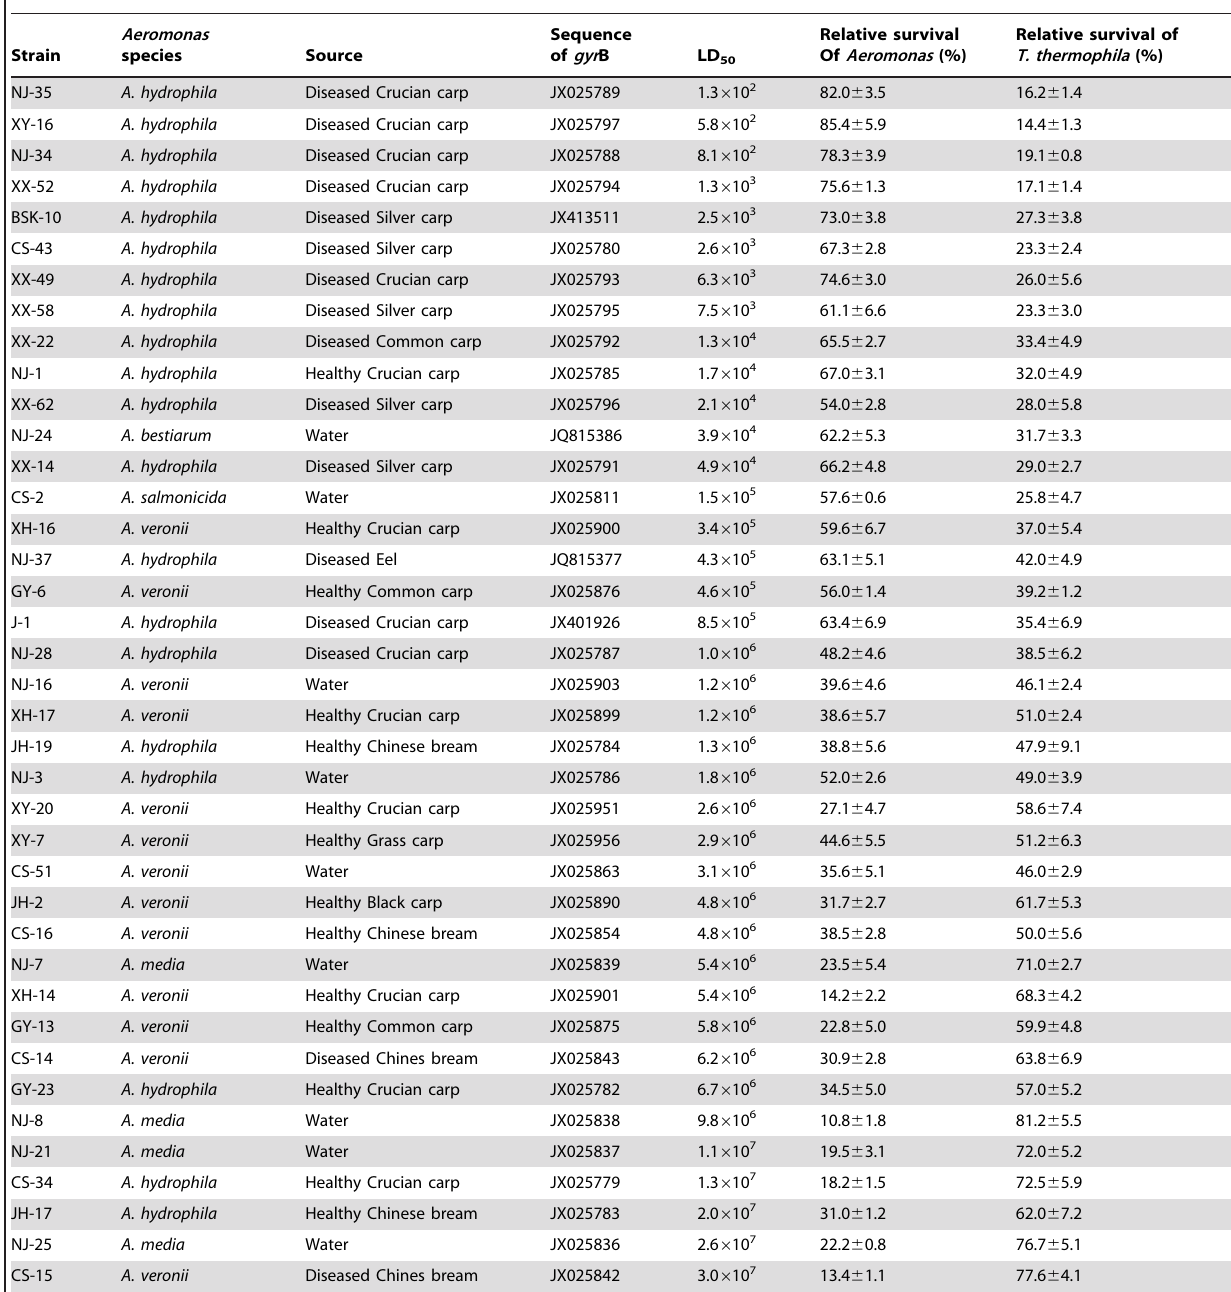
Table 1. Virulence of 39 Aeromonas strains assessed in zebrafish and T. thermophila